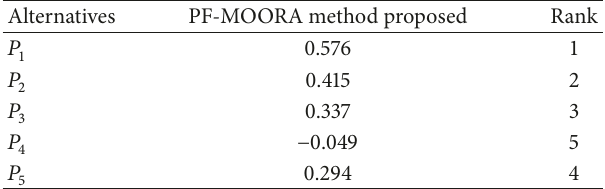
Table 10: Rank for each alternative.